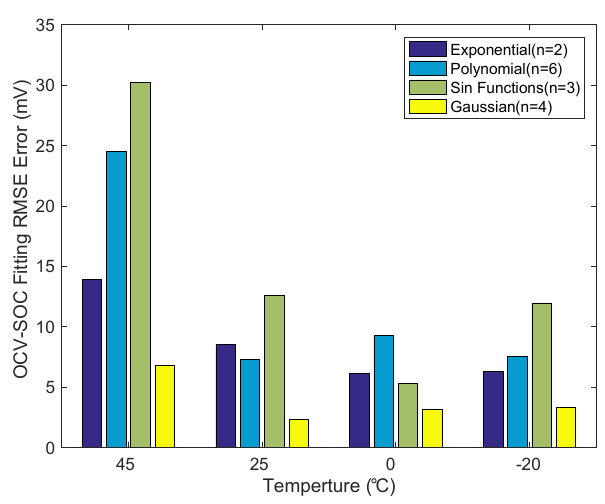
Figure 10. Compare of the 4 types fitting model RMSE.